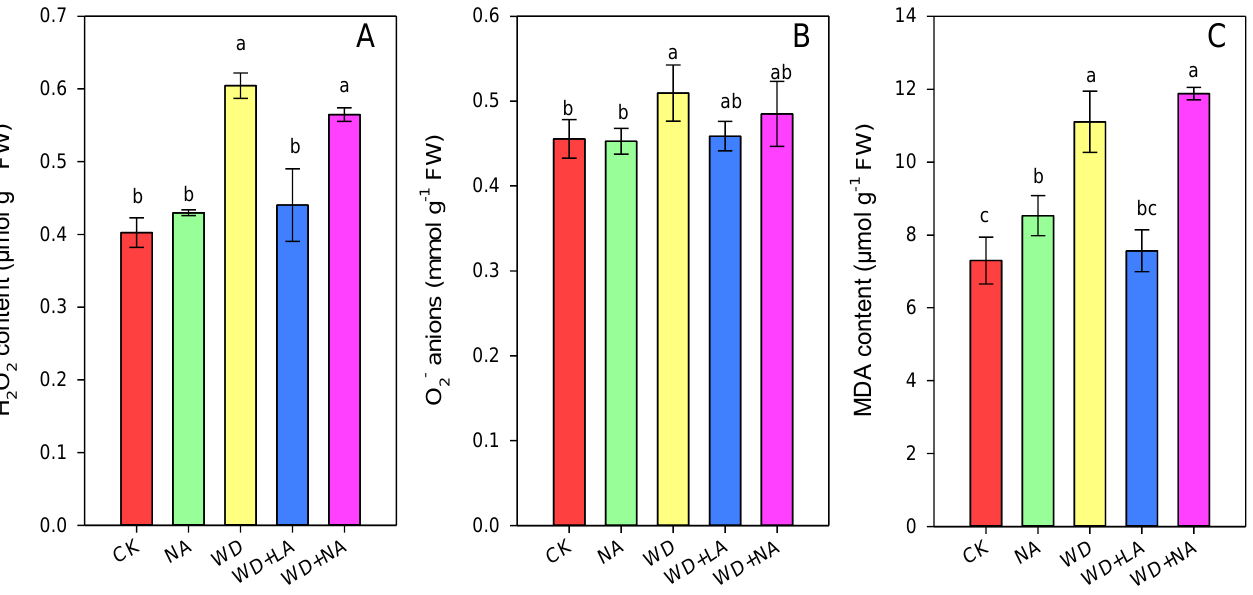
Figure 5. The H 2 O 2 ( A ), O 2 •− anions ( B ), and MDA contents ( C ) of maize seedlings under drought stress conditions. CK: control treatment; NA: 25 μmol L −1 of L-NAME; WD: 20% PEG; WD + LA: 20% PEG + 150 μmol L −1 of L- arginine; WD + NA: 20% PEG + 25 μmol L −1 of L-NAME. The results are presented as the means ± standard error ( n = 3). Significant differences are represented by the lowercase letters ( p ≤ 0.05) b ased on the LSD test. Lowercase letters above the error bars in ( A – C ) indicate significant differences among the five treatments ( p < 0.05). H 2 O 2 , hydrogen peroxide; L-NAME, N γ -nitro-L-arginine methyl ester; LSD, least significance difference; MDA, malondial- dehyde; O 2 • − , superoxide anion; PEG, polyethylene glycol.